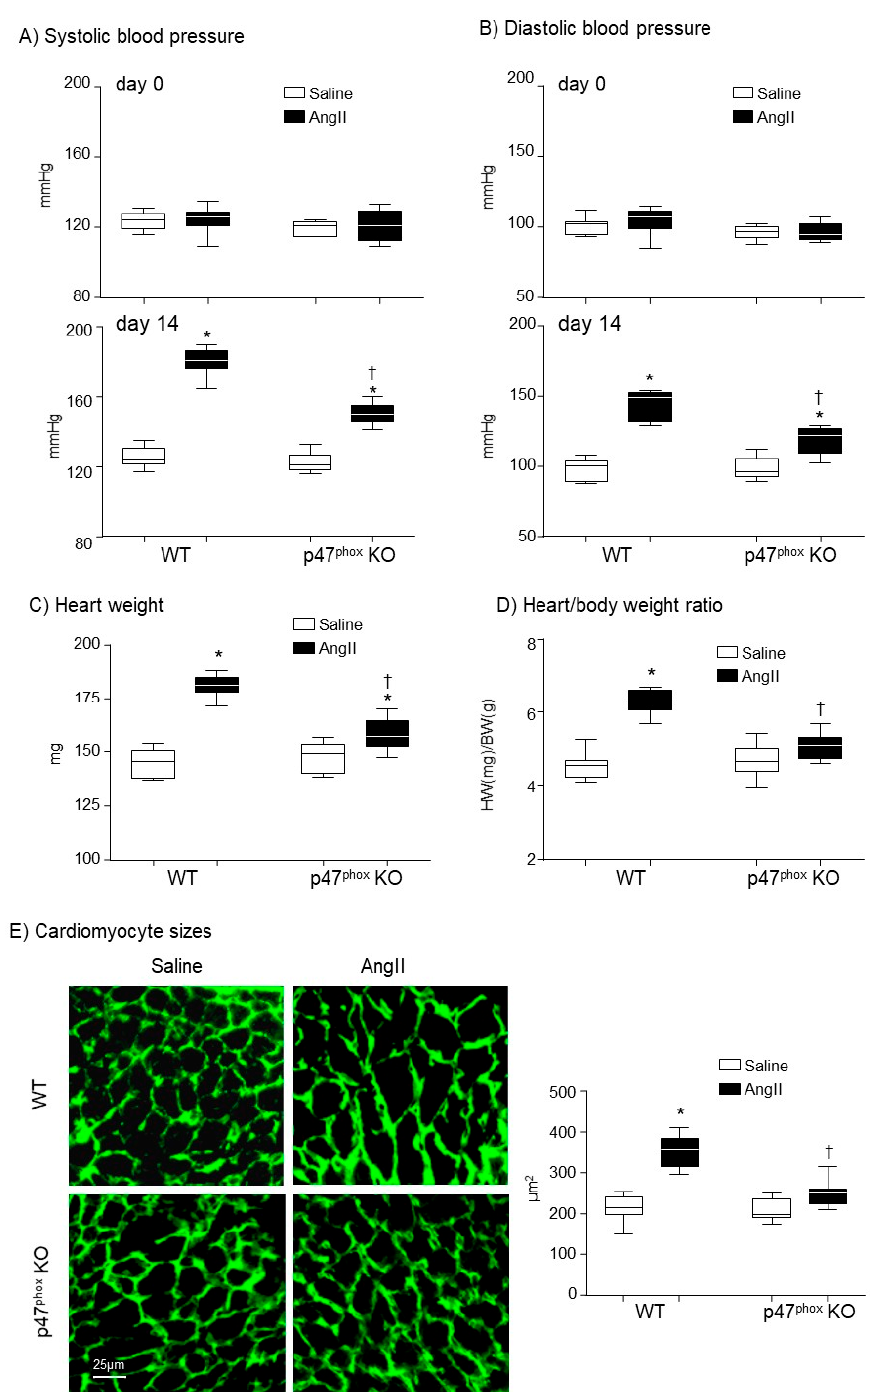
Figure 1. Development of hypertension and cardiac hypertrophy in AngII ‐ infused WT and p47 phox KO mice. ( A ) Systolic blood pressure. ( B ) Diastolic blood pressure. Day 0: day of minipump implantation. Day 14: day of minipump removal. ( C ) Heart weights. ( D ) Heart weight (HW, mg)/body weight (BW, g) ratio. ( E ) Left panels: Representative images of cardiomyocyte sizes on the cross ‐ sections of left ventricular tissues. The cardiomyocytes membranes were labelled with WGA ‐ FITC (green). Right panel: Statistical analysis of cardiomyocyte cross ‐ sectional areas ( μ m 2 ). n = 9 mice per group. Statistical analyses were performed using two ‐ way ANOVA. * p < 0.05 for AngII values versus saline values in the same genetic group; † p < 0.05, for p47 phox KO AngII values versus WT AngII values.